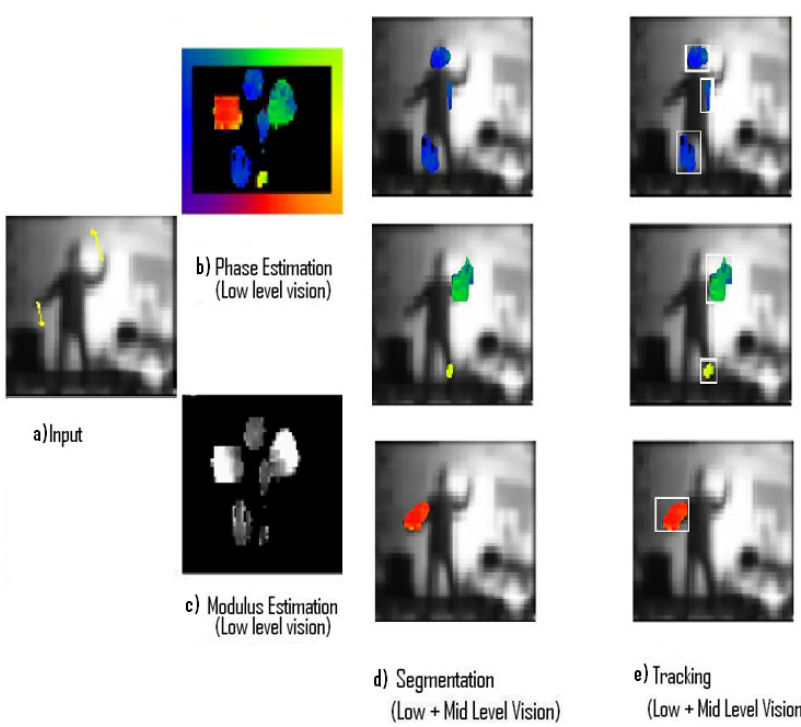
Figure 4. Results from Experiment